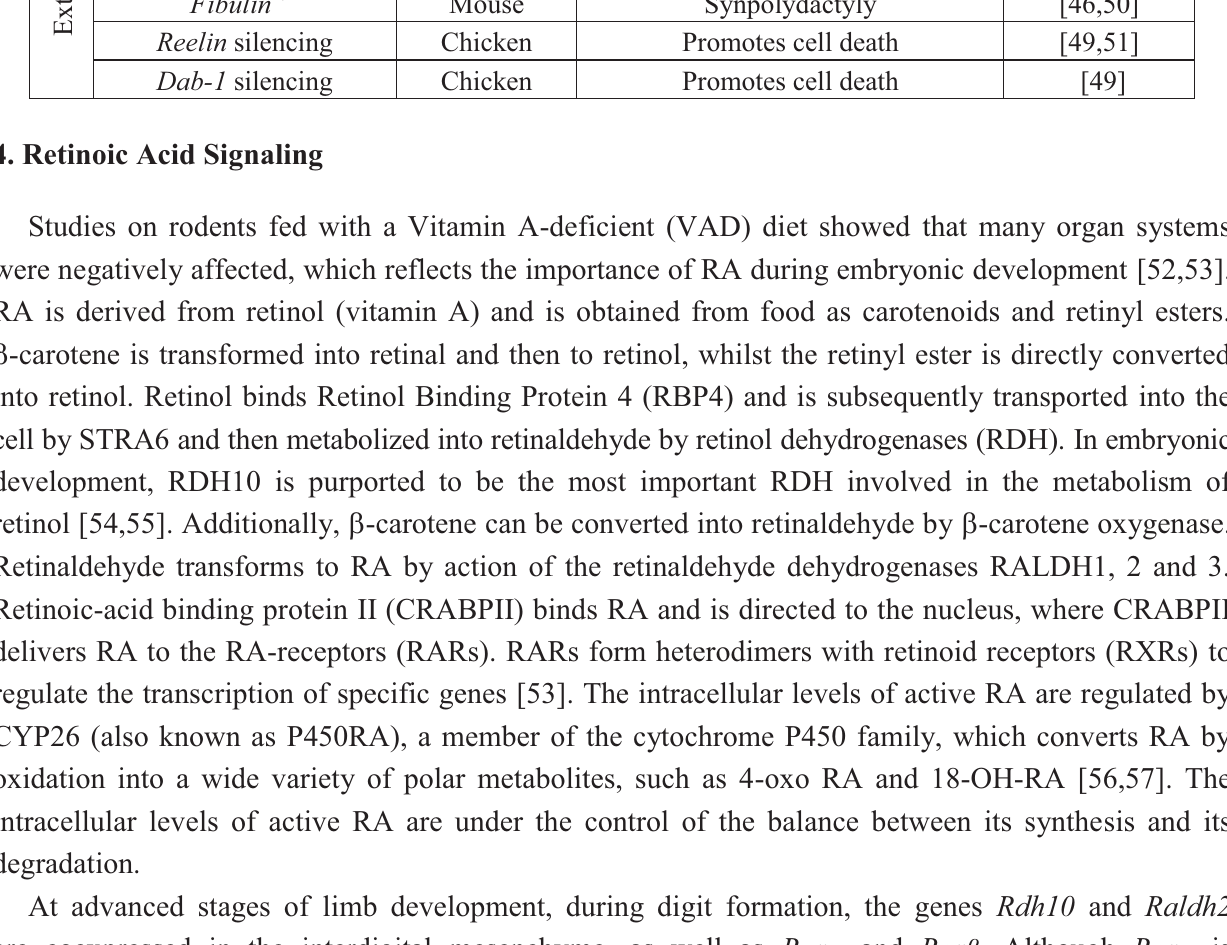
r i a t M a r u l ll ace r x t E